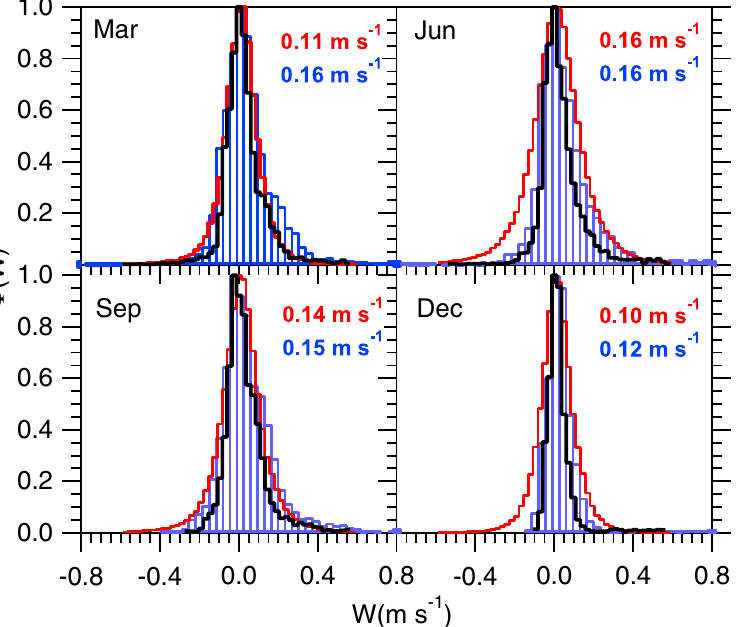
Figure 1. Vertical velocity (m s − 1 ) distribution within cirrus at the SGP site from cloud Doppler radar measurements 13 (red lines) and high resolution simulations (blue bars). Measurements correspond to the period 2000–2010 and model results to 2005–2007. Scaling was applied to the model results as described in Methods. Black lines represent the “unscaled distribution” from the G5NR. Positive W values indicate updraft. The legends correspond the mean value of σ w for each